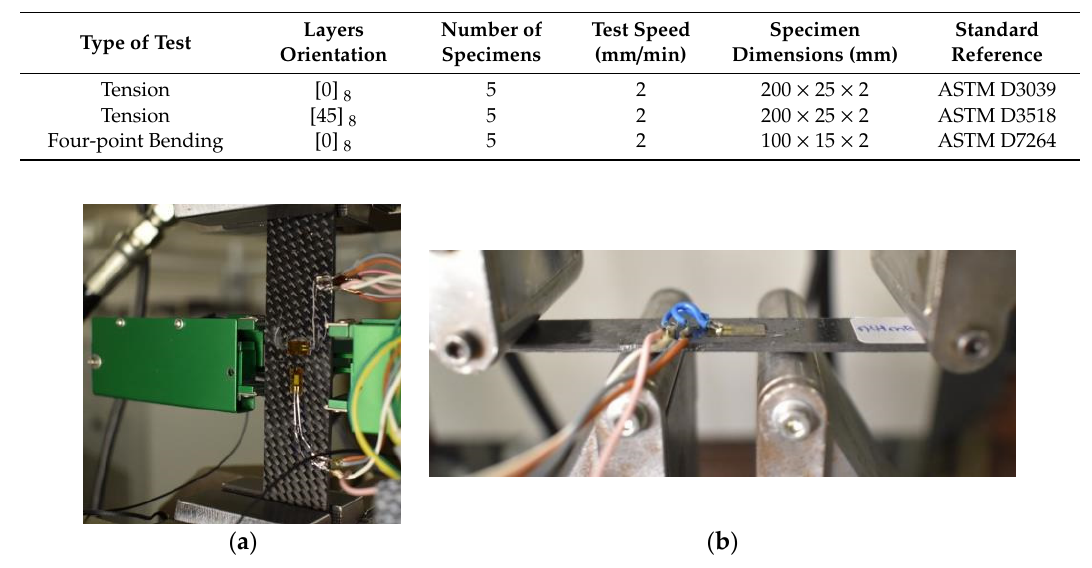
Figure 3. Experimental setup of Tensile test ( a ) and Bending test ( b ).